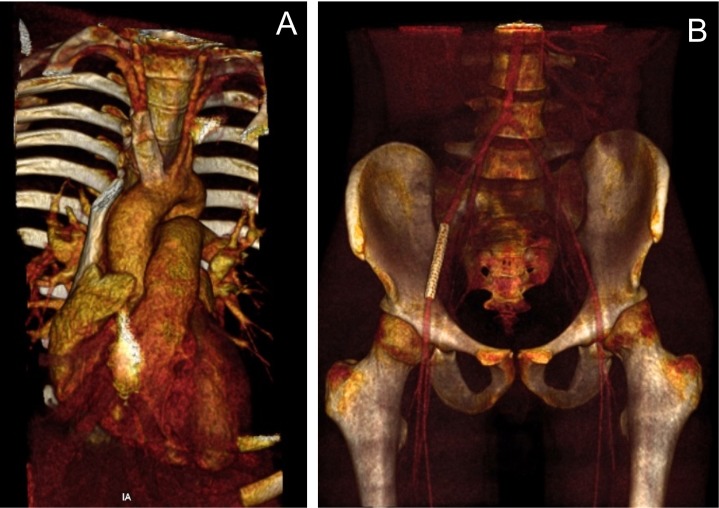
Reconstructed images from control angiotomography after treatment to repair aneurysm of the brachiocephalic trunk (A) and external iliac bleeding (B).